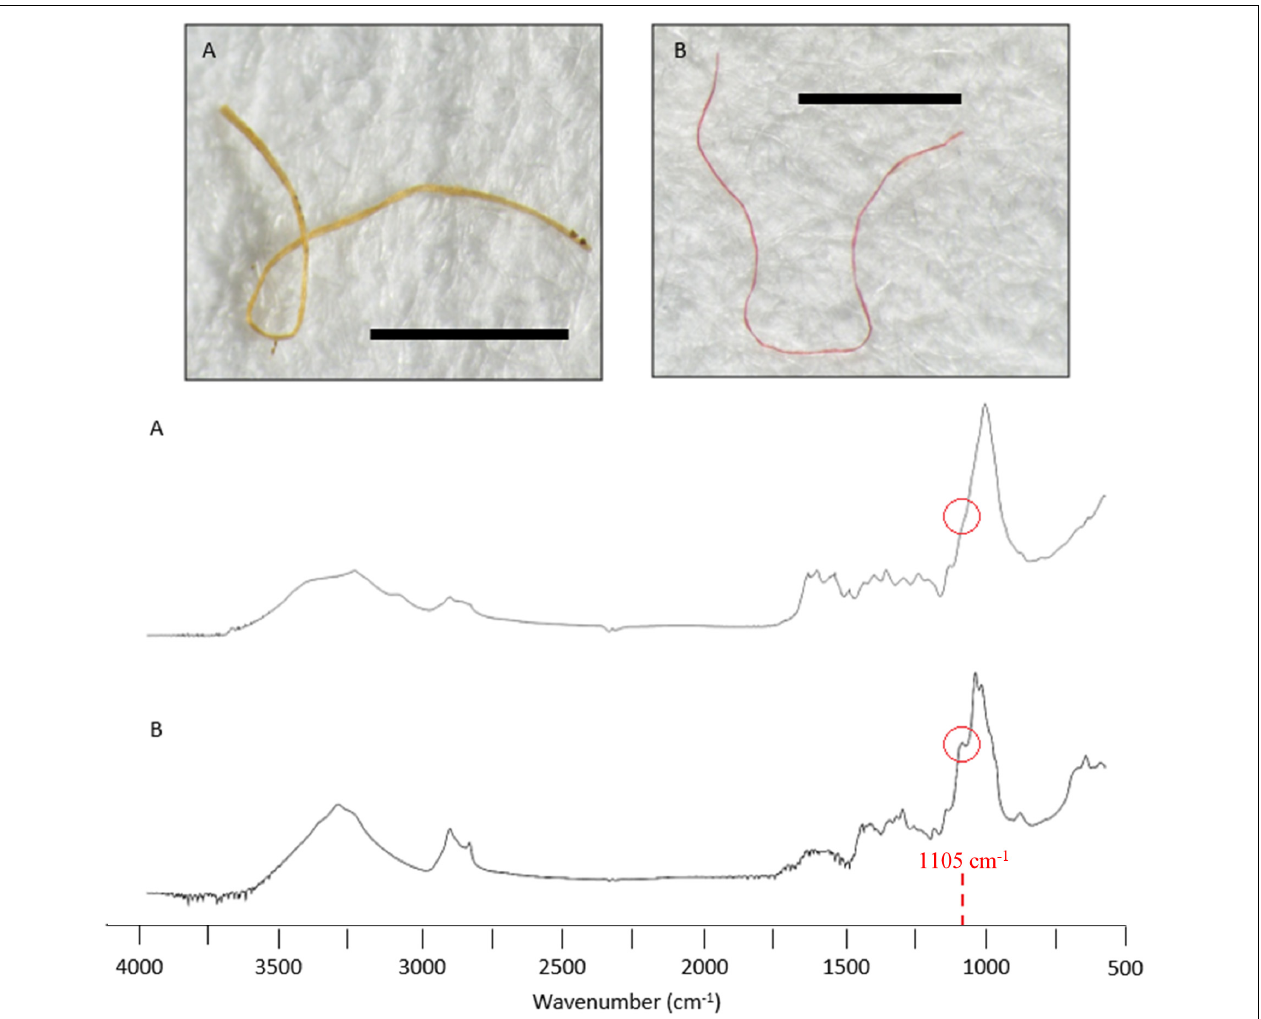
FIGURE 6 | Spectral comparison of two cellulose-based fibres recovered from the gastrointestinal tract of sardines caught in Frenchman Bay, Western Australia in January 2019. Sample (A) was classified semi-synthetic due to the absence of a spectral peak at 1105 cm − 1 . Sample (B) was classified natural due to the spectral peak at 1105cm − 1 . Image scalebars represent 1